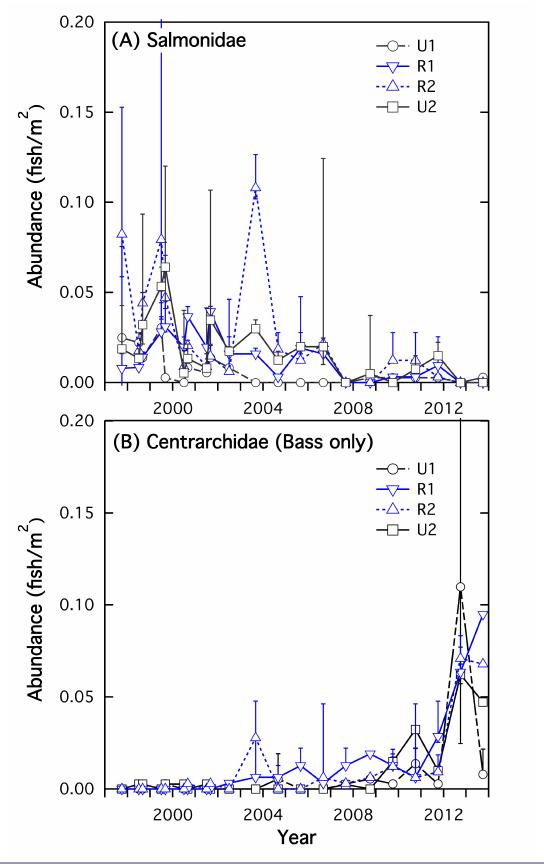
Fig. 5 . Population estimates of (A) introduced Salmonidae (brown trout, rainbow trout) and (B) native Centrarchidae (rock bass, smallmouth bass, largemouth bass) from multiple- pass data for each 60-m reach (prerestoration in 1997; postrestoration 1998 through 2013). Error bars indicate 95% confidence